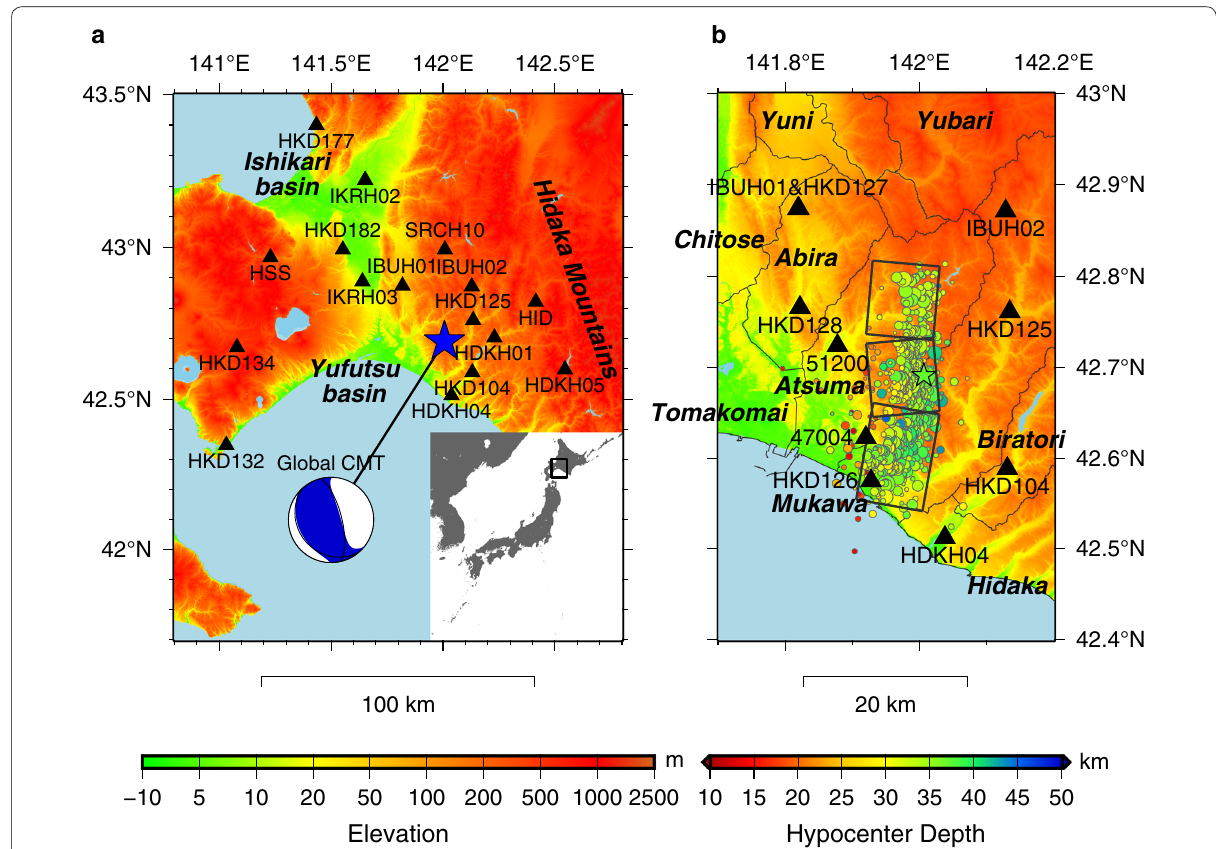
Fig. 1 Index map of the study area. The topography is plotted using the post-processed SRTM 90 m Digital Elevation Data v4.1 (Jarvis et al. 2008). a Map showing the locations of the strong-motion stations used for the source inversion study (solid triangles). Location of the epicenter is indicated by the blue star with its moment tensor solution by the Global CMT Project. b The map shows the epicenters of the aftershocks within a day from the mainshock (color circles). The rectangles correspond to the surface projection of the assumed fault model for the source inversion analysis. The solid triangles show locations of strong-motion stations. Thin gray lines represent the municipality